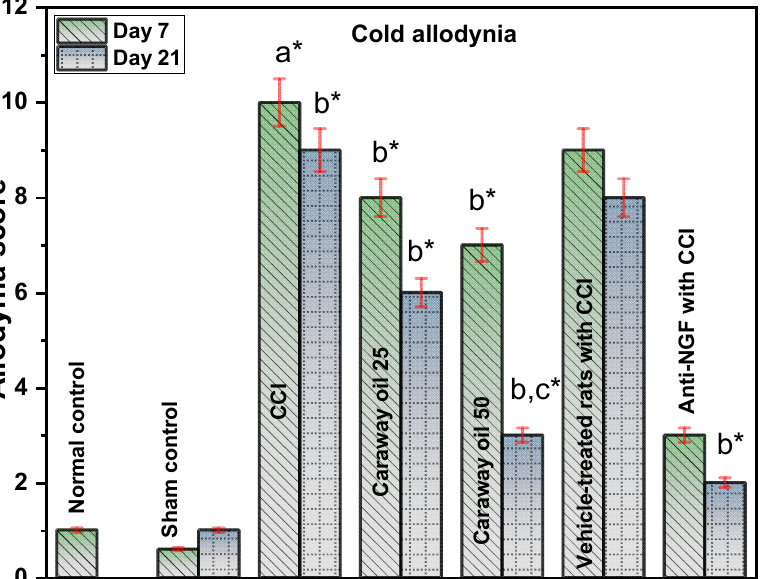
Figure 1. Evaluation of the effect of caraway oil on CCI-induced paw cold allodynia using the acetone sprinkling test. It is represented as mean ± SEM; n = 6. a p ≤ 0.05 against sham control correspondent to the same day. b p ≤ 0.05 against CCI comparable to the same day. c p ≤ 0.05 versus caraway oil and anti-NGF in CCI compatible to the same day. * represents p -value ≤ 0.05.